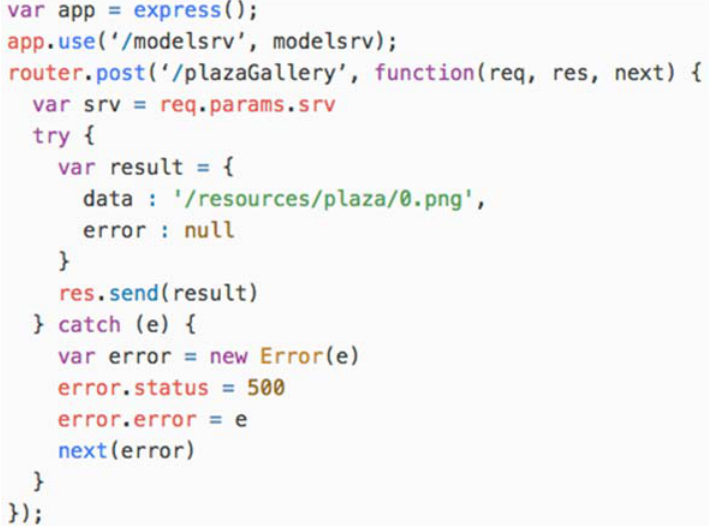
Figure 11. Fragment of code generated by the transformation for the remote model configuration.